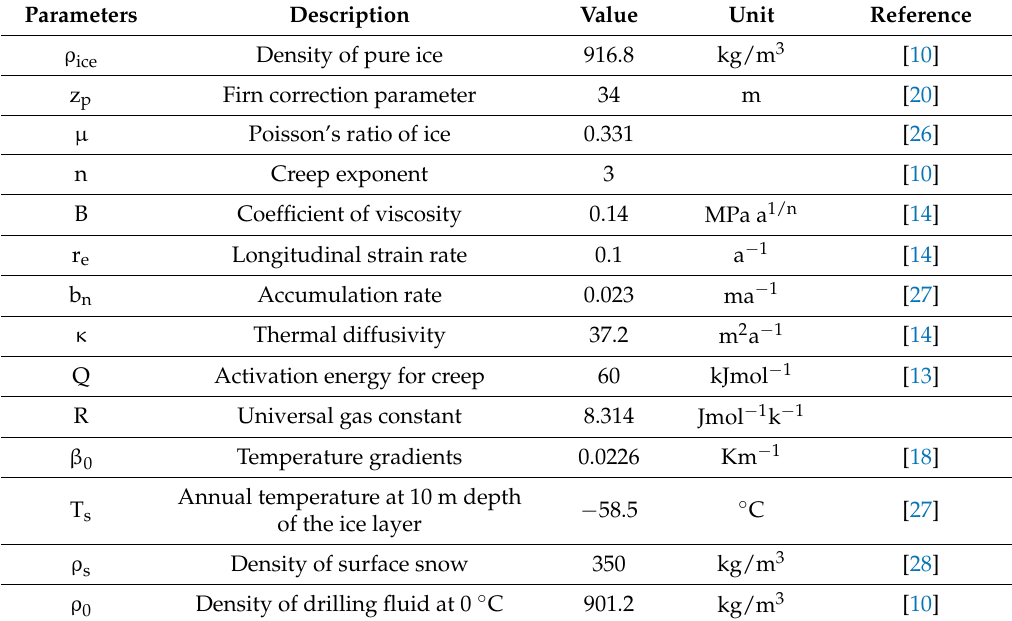
Table 1. Parameter values for the Dome A